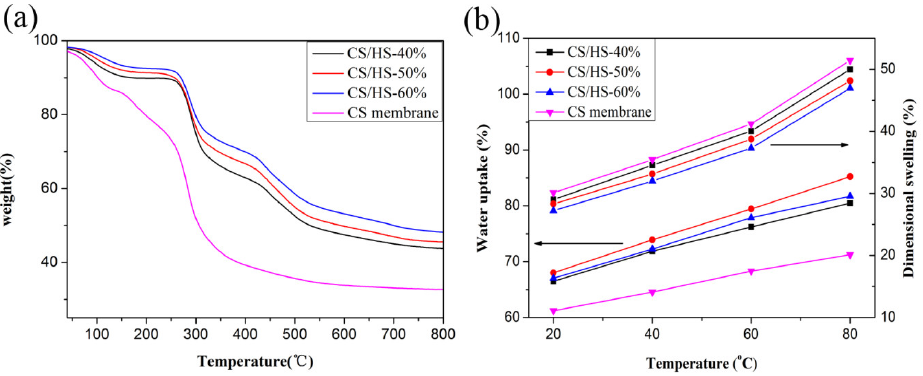
Figure 3. ( a ) TGA curves; ( b ) water uptake and dimensional swelling of all the samples.